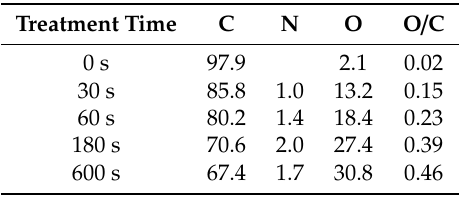
Table 1. XPS surface composition of PS covered with the MgF 2 optical window and exposed to Ar atmospheric pressure plasma jets (APPJ) at various treatment times.